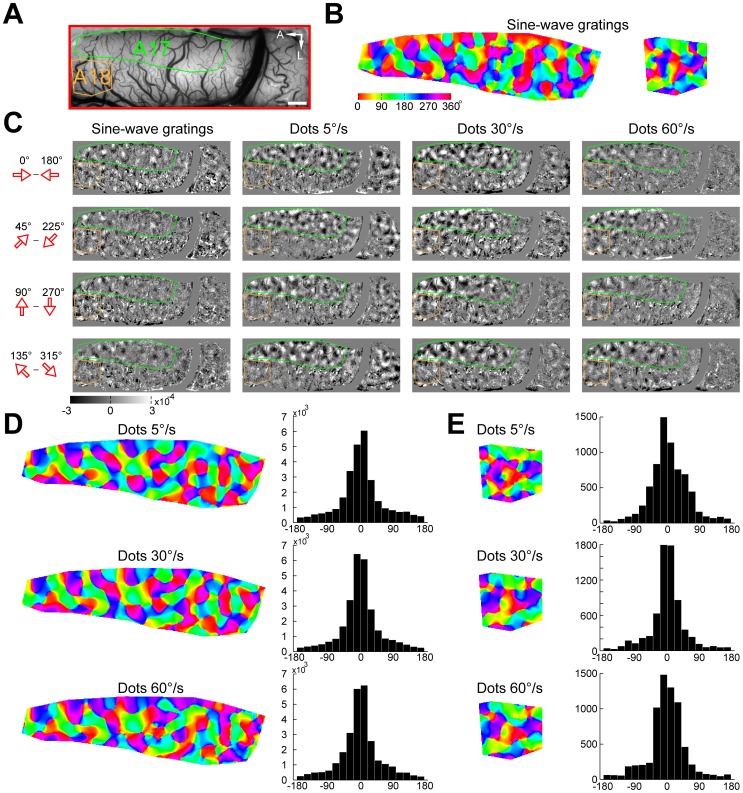
Direction preference maps calculated by vector summation were not changed with moving speed of random-dot stimuli.(A) Image of the cortical vasculature. The green and orange polygons indicate regions of areas 17 and 18 selected for analysis, respectively. A, Anterior; L, lateral. Scale bar: 1 mm. (B) Direction preference maps calculated by vector summation acquired using sine-wave grating stimuli in areas 17 and 18. Hues in the color maps indicate direction preferences. (C) Differential direction maps activated by four different pairs of directions of moving sine-wave gratings and random dots with different speeds. (D–E) Direction preference maps calculated by vector summation acquired using random-dot stimuli with different speeds in areas 17 (D) and 18 (E). Angular differences between direction preference maps of sine-wave grating and of random-dot stimuli with different speeds are shown in the histograms. Computed from the angular-difference histograms of 5°/s, 30°/s, and 60°/s,the percentages of pixels with angular difference between −60° and 60° amount to 73%, 78%, and 75% in area 17 (D) and 78%, 82%, and 80% in area 18 (E), respectively.